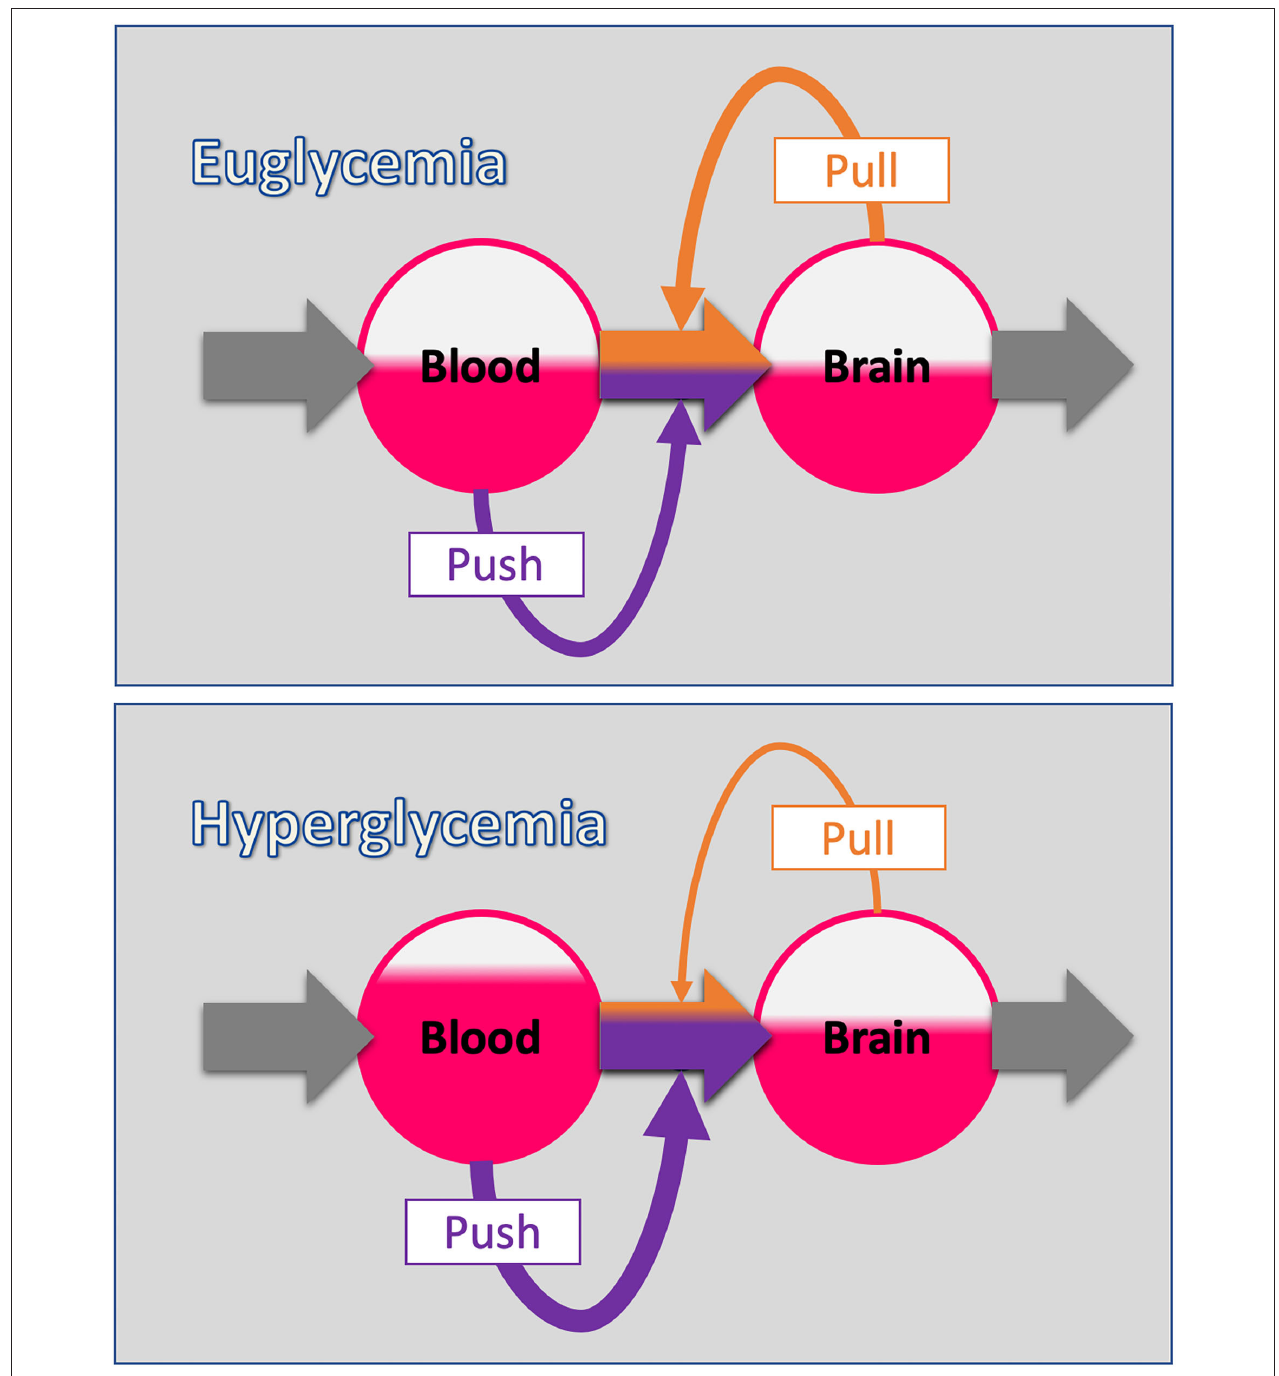
FIGURE 2 | The push-pull principle in the cerebral supply chain. (Upper panel) The blood-to-brain energy flow is determined by two components: The push-component depends on the energy level of the blood (blood glucose). The pull-component depends on the energy level of the brain (intraneuronal ATP). This principle corresponds to the economic concept of “supply and demand.” (Lower panel) When the blood energy content increases (hyperglycaemia), the blood-push component increases and with it the proportion of the blood-to-brain flow determined by the blood (purple share of flow). Note that the energy level in the respective station of the supply chain is indicated by the area coloured red. Oversupply by an increased blood-push leads compensatory to a reduction in the brain-pull component decreasing the proportion of blood-to-brain flow determined by the brain (orange share of flow). In this way, fluctuations in the energy level of the end consumer (the brain in this case) are minimised, which basically is the function of supply chains.